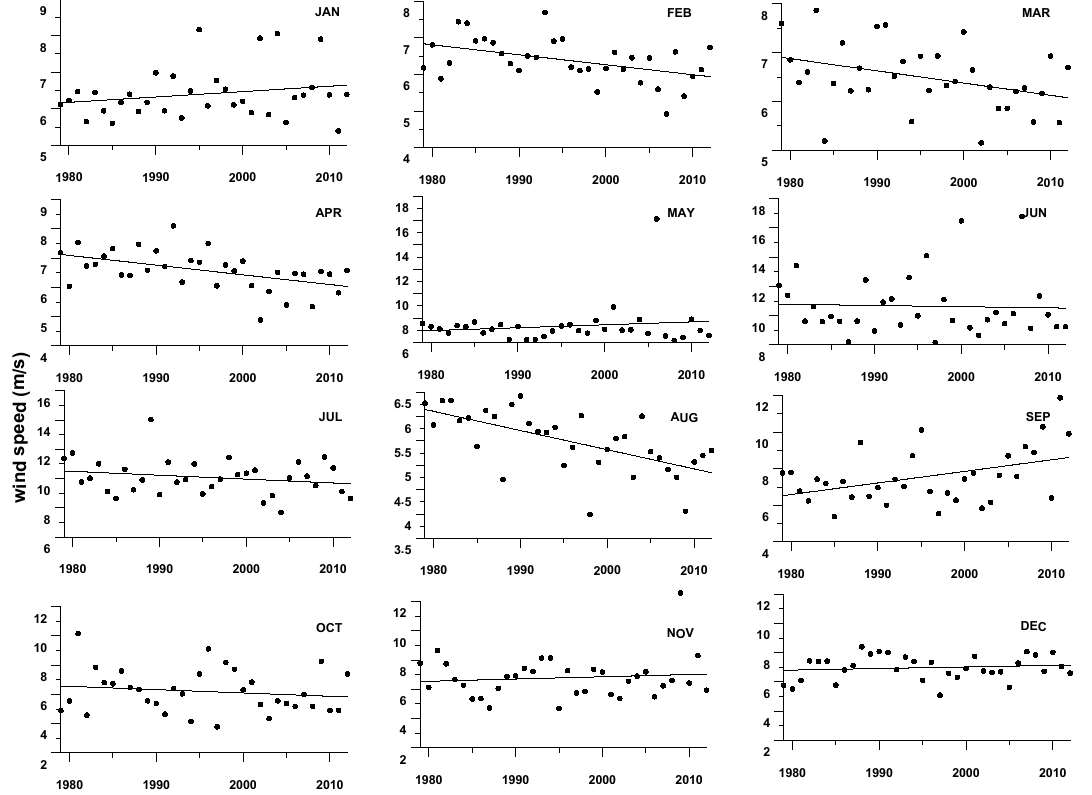
Figure 3. Temporal variation in the monthly maximum wind speed from 1979 to 2012. Figure 3.Temporal variation of monthly maximum of wind speed during 1979-2012 456 action) to carry out a relevant statistical analysis. The 90th and 99th percentile values show decreasing trends (1.9 and 1.6 cm s − 1 year − 1 ) similar to the trend of annual mean wind speed (1.5 cm s − 1 year − 1 )